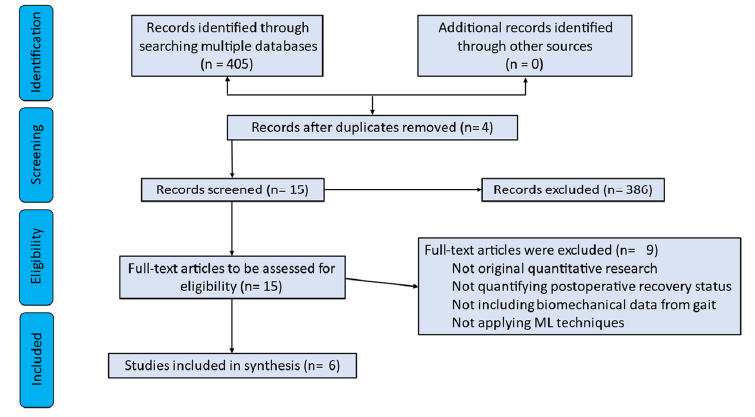
Figure 2. Flow chart of the proposed literature search.